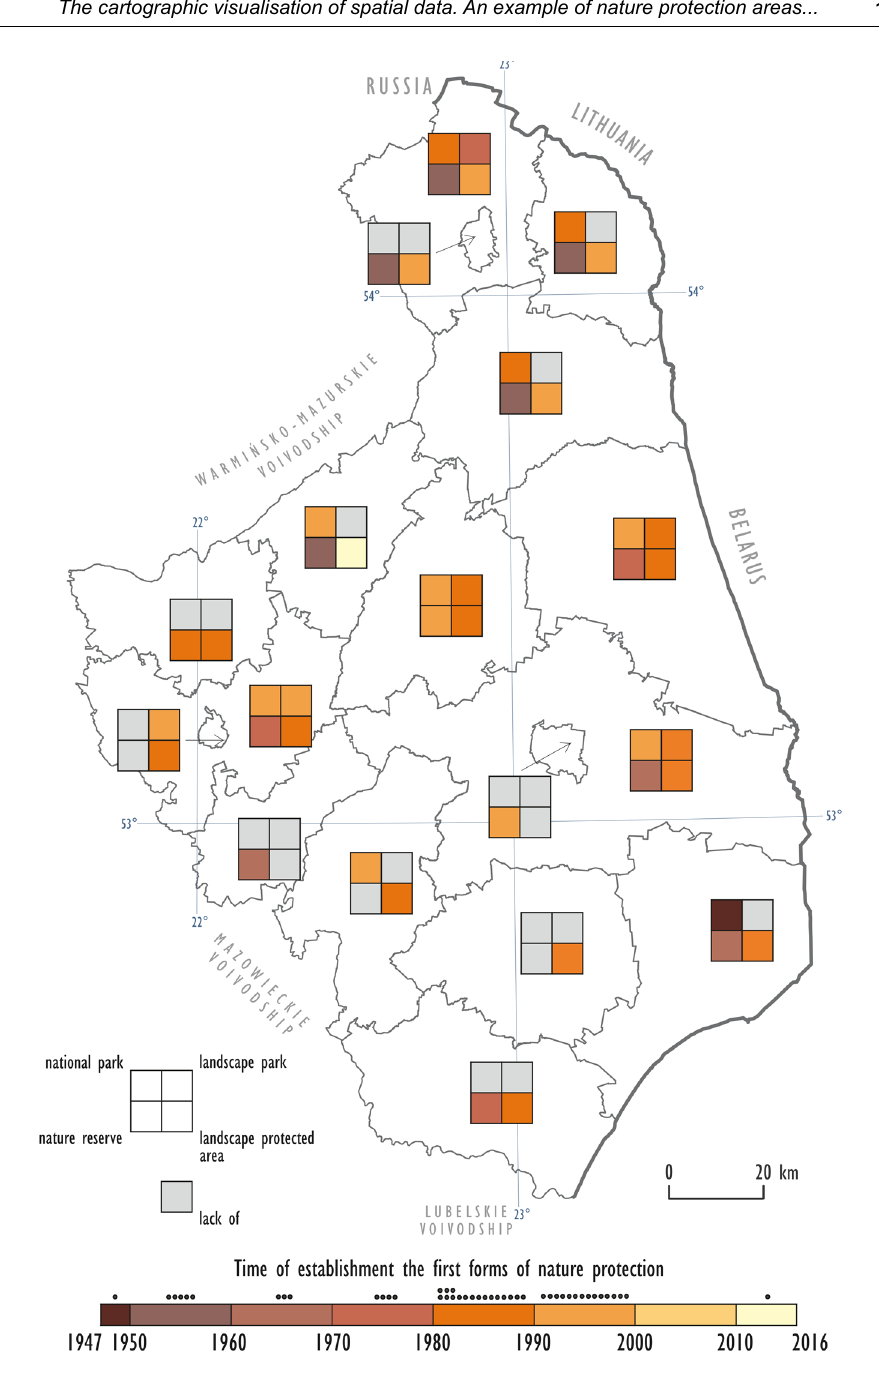
Fig. 12. Time of establishment the first forms of nature